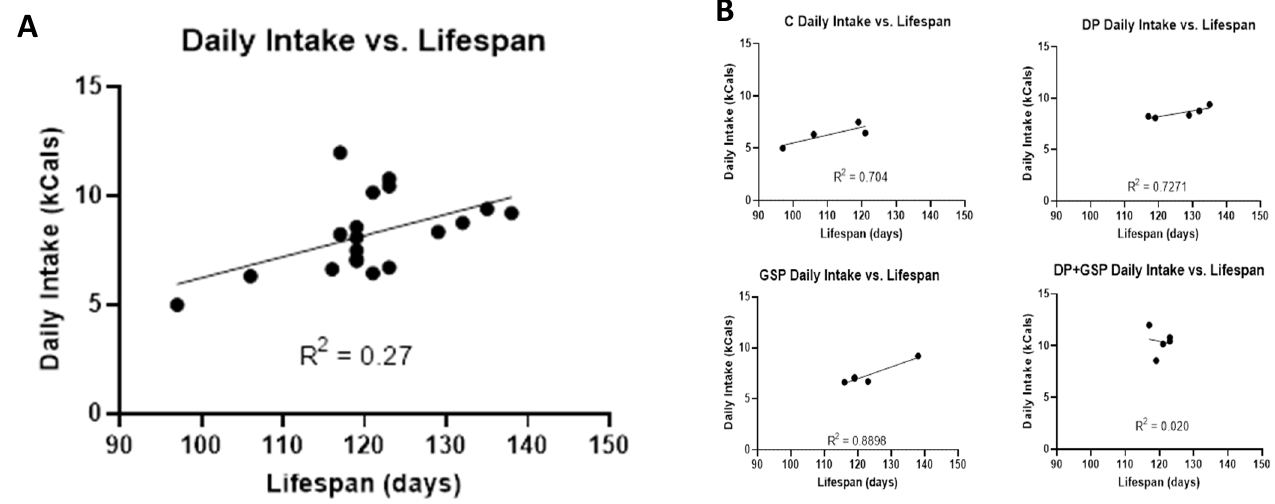
Figure 5. Daily Intake vs. Lifespan. Graphs depicting linear regression of average daily caloric intake versus lifespan. ( A ) When data from all the groups were plotted, there was a positive correlation between average daily food energy consumed and survival (R 2 = 0.2565). ( B ) When data from each group were plotted individually, three of the groups displayed strong positive correlations (R 2 values for C, DP, and GSP were 0.704, 0.7271, and 0.8898, respectively). However, no such correlation was found for the DP+GSP group (R 2 = 0.0203).